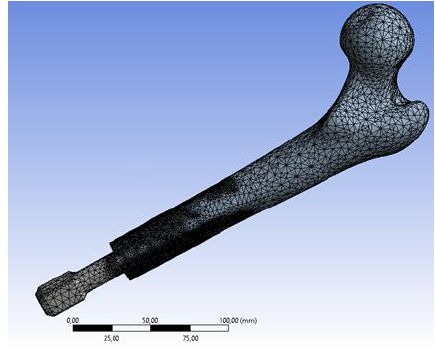
Figure 7. Meshed model (screw type prosthesis).